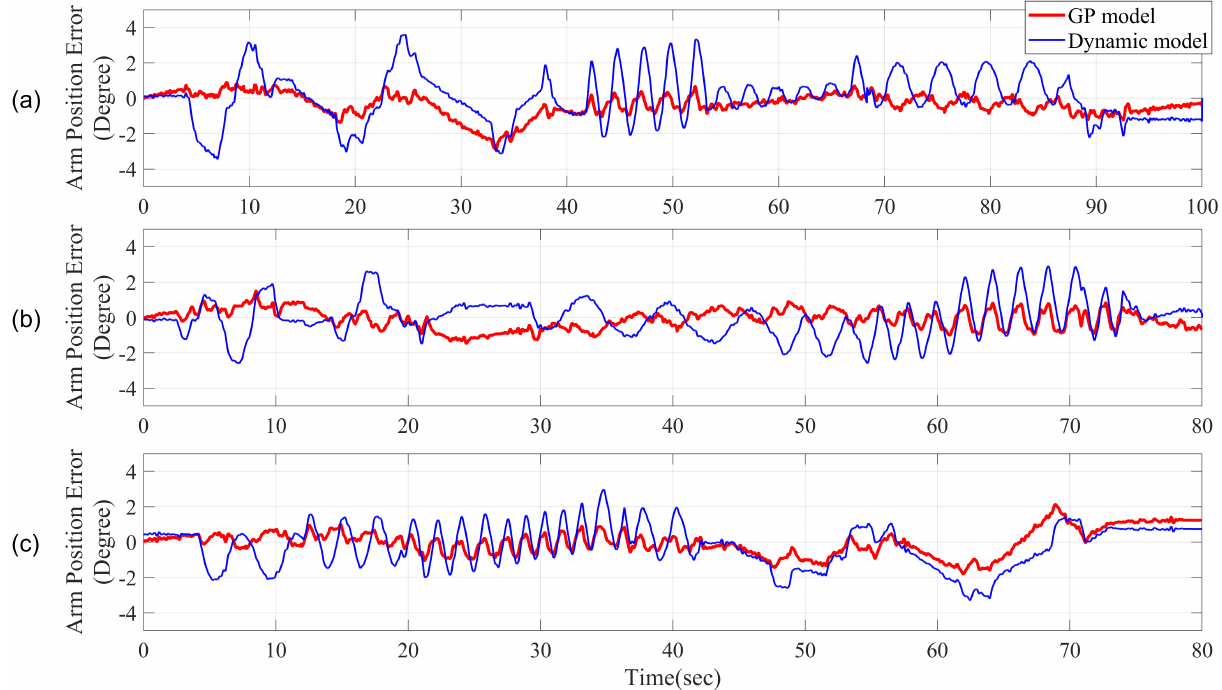
Figure 13. Arm position error for two methods with respect to the experimental data, ( a ) first validation dataset, ( b ) second validation dataset, ( c ) third validation